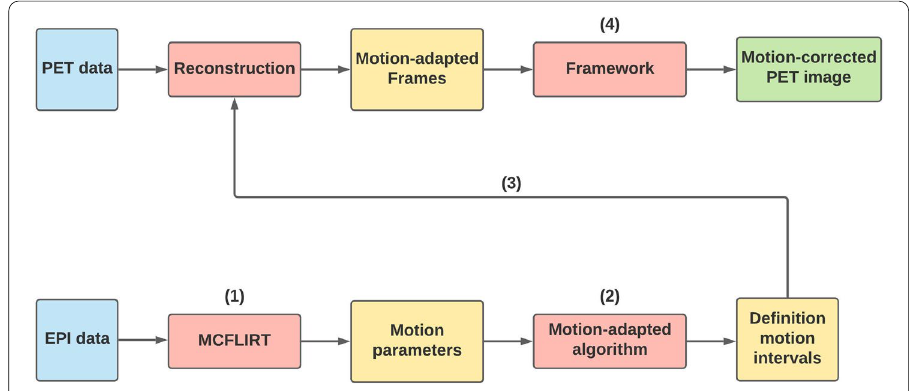
Fig. 5 Framework for motion-adapted reconstruction using MCFLIRT. (1) MCFLIRT was applied to the EPI data. (2) An algorithm then determined the frames to be reconstructed. (3) Based on the defined movement intervals, the PET data were reconstructed on the Siemens console. (4) The framework from Fig. 4 was used to obtain a motion-corrected